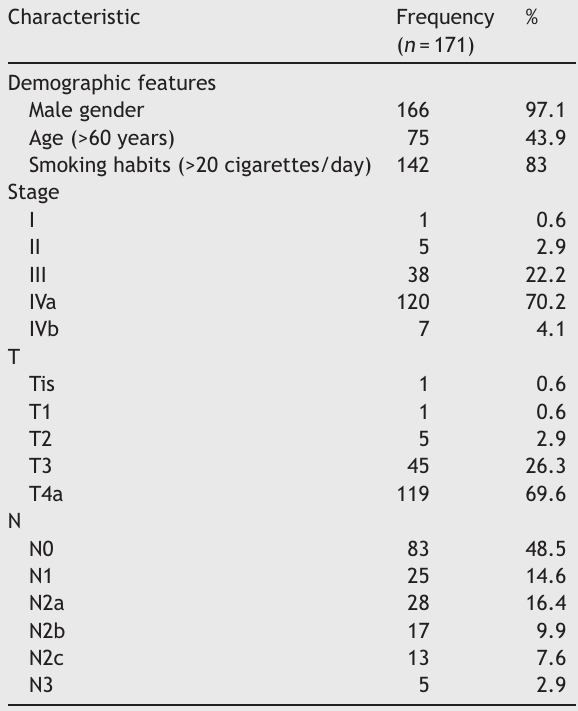
Characterization of the sample according to TNM stage (AJCC Cancer Staging Manual, 2010 --- 7th edition) and demographic features.